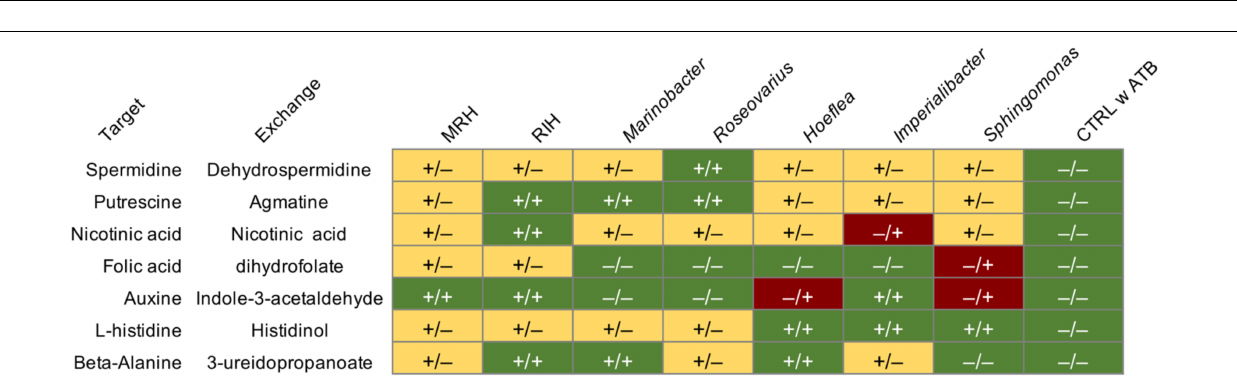
FIGURE 2 | Morphological effect co-cultures with bacteria on E. siliculosus after 4 weeks of co-culturing. Panels (A–G) correspond to different bacterial inoculations, panels (H,I) to controls. MRH, Marinobacter – Roseovarius – Hoeflea ; RIH, Roseovarius – Imperialibacter – Hoeflea .